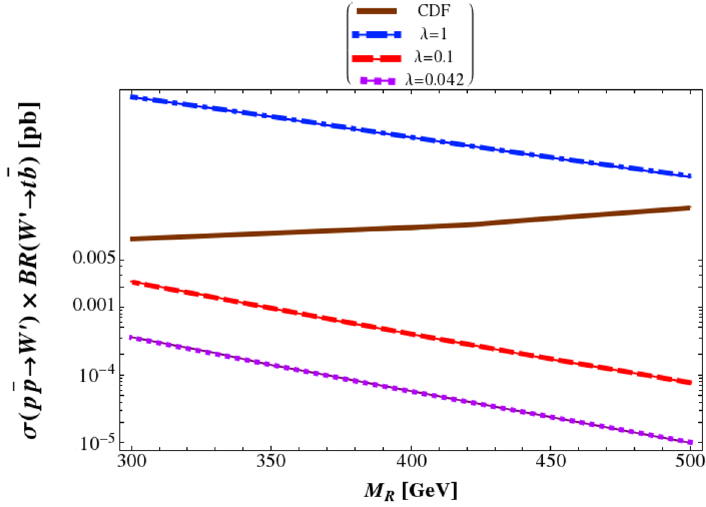
¯ ) × BR ( W + Figure 3 . Bound on σ ( p ¯ p → W + → t b ) as a function of M R for λ = 1 (blue, dash- R R dotted line), λ = 0 . 1 (red, dashed line) and λ = 0 . 042 (purple, dotted line). The solid brown curve represents the upper experimental limit obtained by the CDF II detector data [53], with an integrated luminosity of 9 . 5 fb − 1 and a center-of-mass energy of 1.96